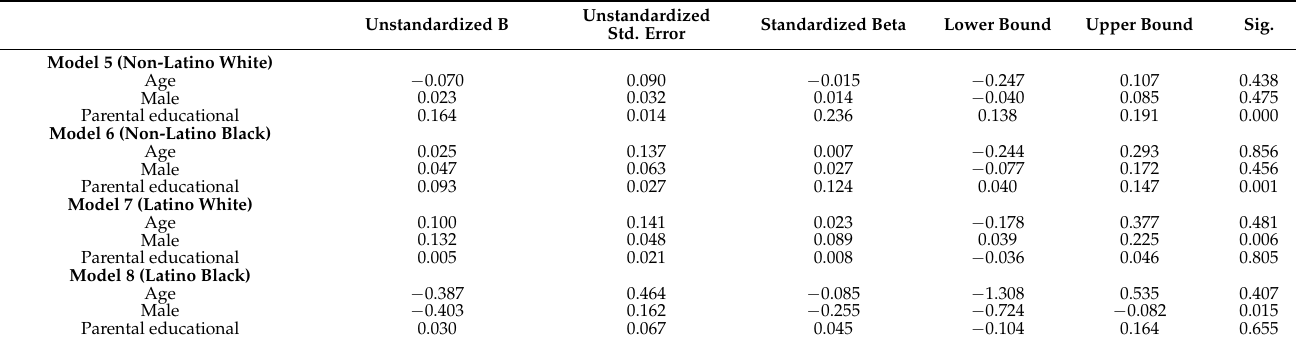
Table 4. Models in race × ethnicity groups. Unstandardized B Unstandardized Std.